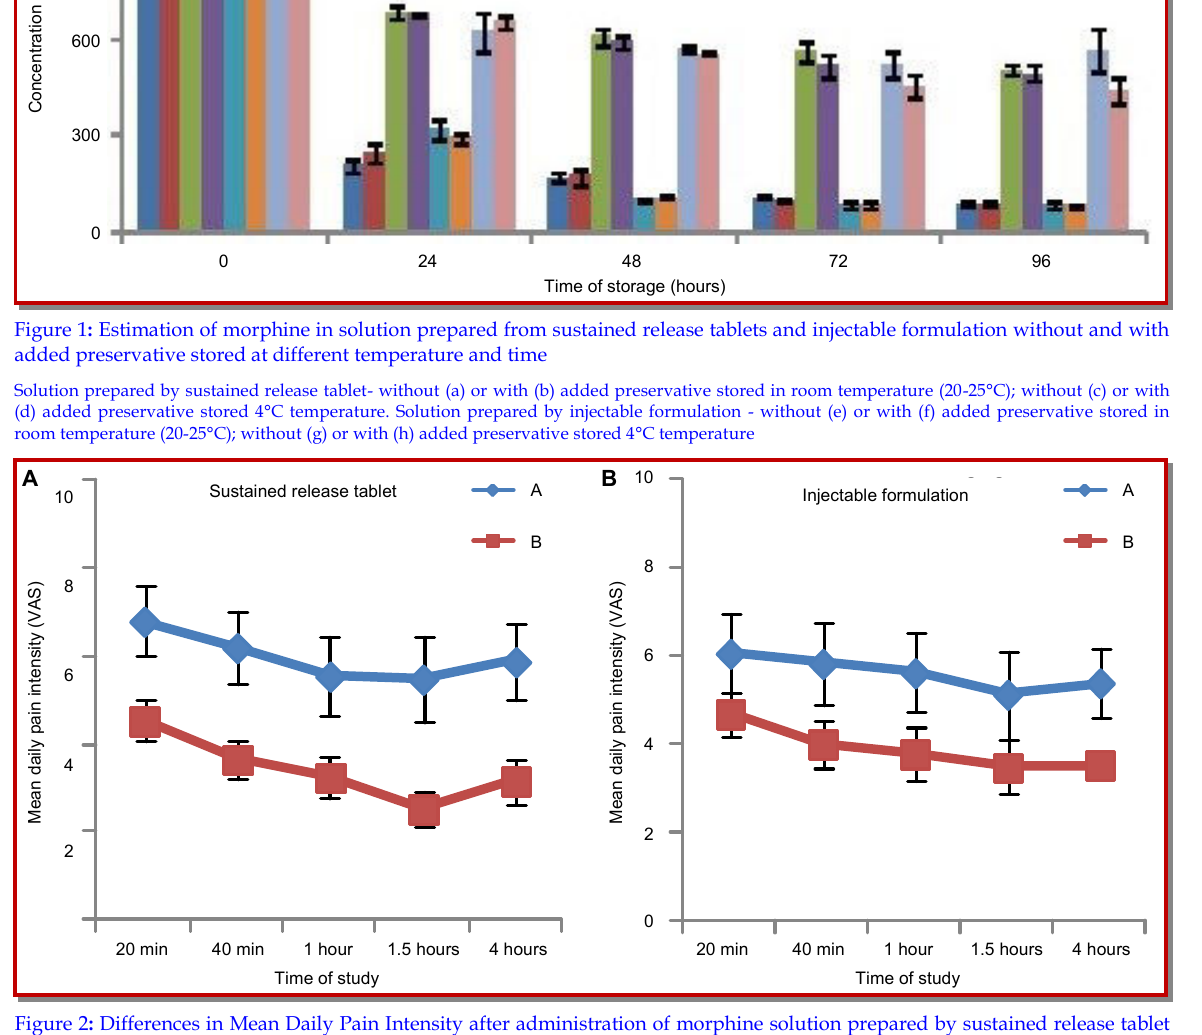
Figure 2 : Differences in Mean Daily Pain Intensity after administration of morphine solution prepared by sustained release tablet (A) and injectable formulation (B) without and with added preservative over a four hour study period A: solution prepared without added preservative; B: solution prepared with added